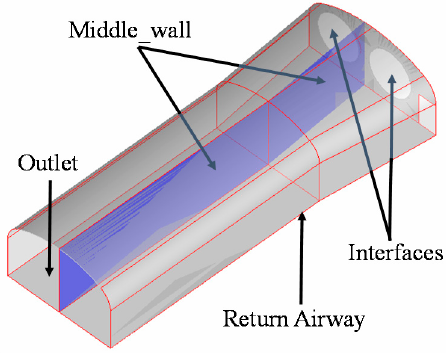
Figure 17. The isolation wall added in the return airway.